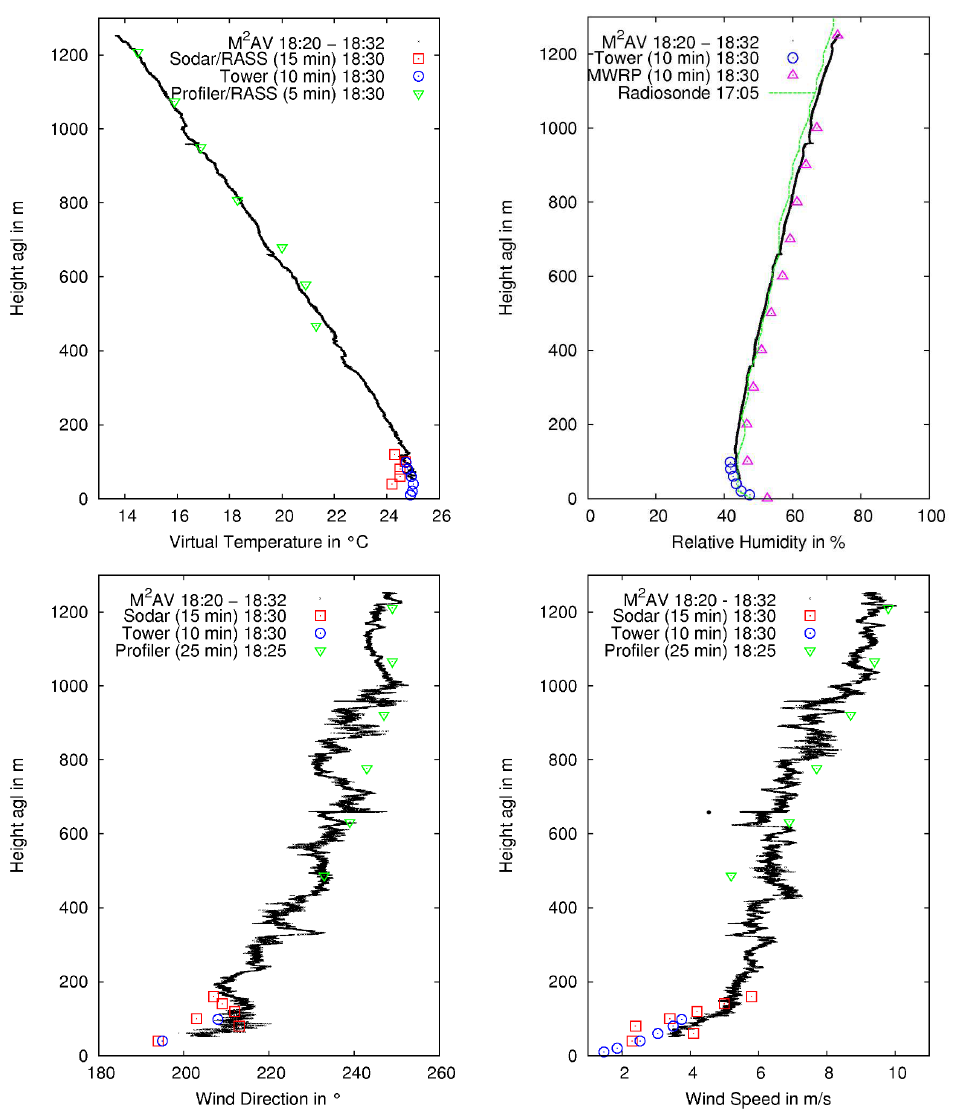
Fig. 9. Vertical profiles measured by wind profiler/RASS, sodar/RASS, tower, MWRP, radiosonde ascent and M 2 AV. These data were collected during the ascent of the afternoon flight of the UAV on 21 July 2009 near MOL-RAO. Besides for the M 2 AV, the times indicated in the captions mark the end of the averaging interval.